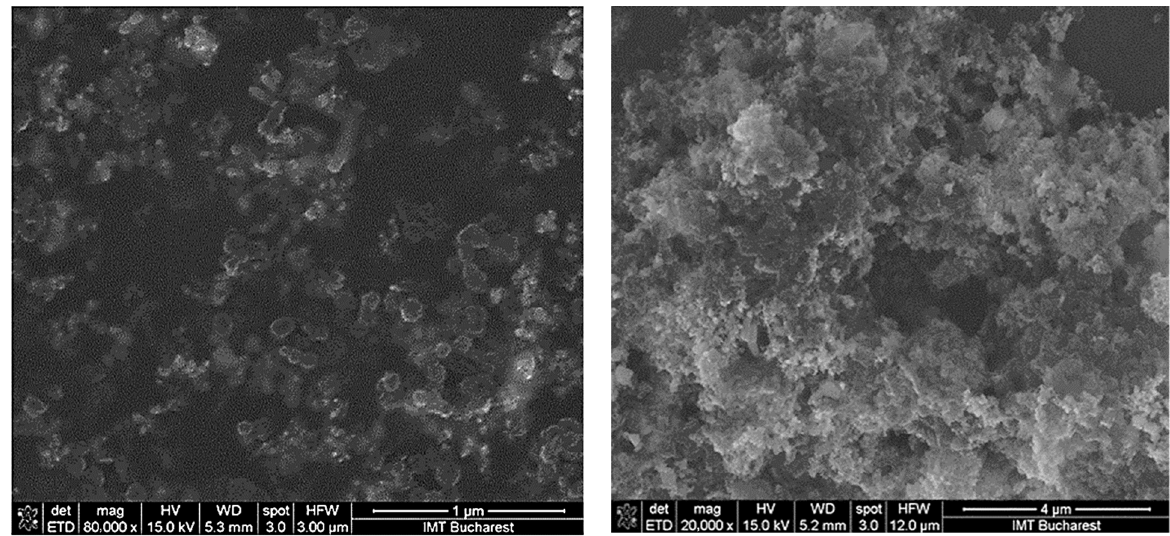
Figure 3. Scanning electron micrographs of the CNHox/SnO 2 /ZnO/PVP = 3/1/1/1, w/w/w/w ratio.